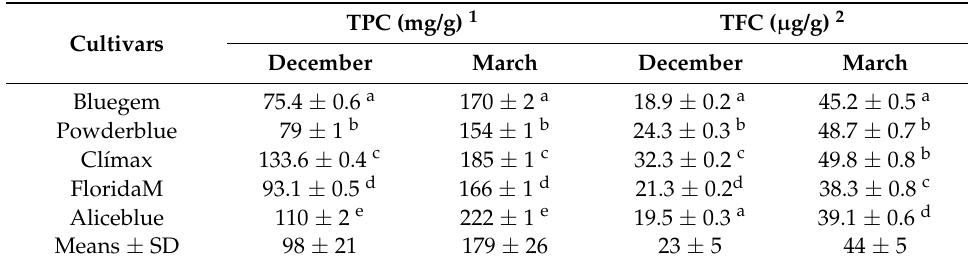
Table 1. TPC and TFC rabbiteye blueberry leaves from different harvest seasons and cultivars.